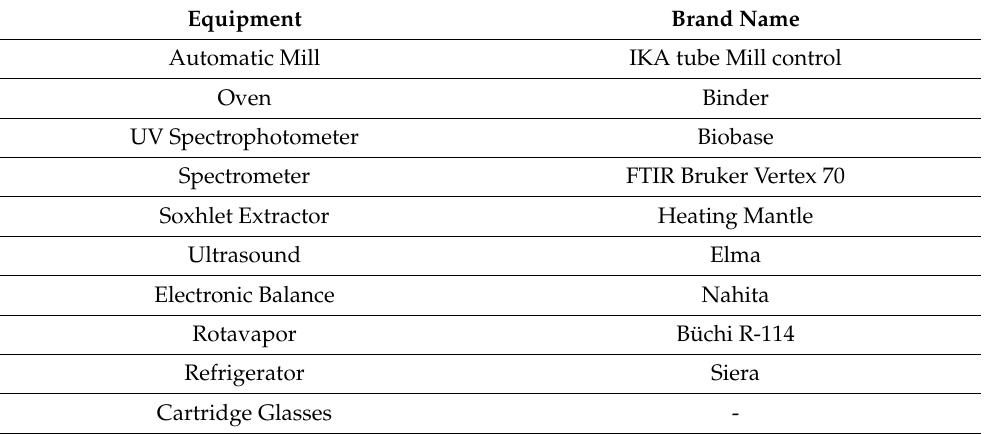
Table 7. Equipment used in this